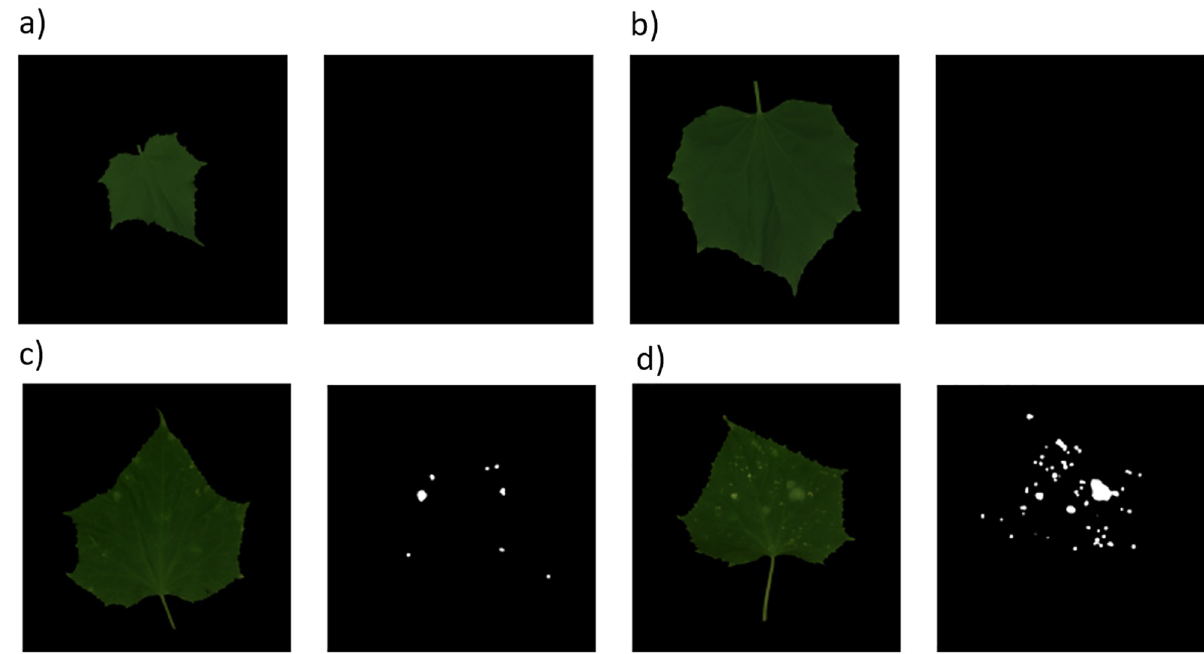
Fig 12. Segmentation masks. The masks, which are produced by a U-net architecture trained with a mix of real and synthetic leaves, denote the diseased spots. The masks are empty for the healthy leaves (a-b), while they indicate disease spots with an accuracy above 94%—according to the segmentation of a human expert—for leaves affected by powdery mildew